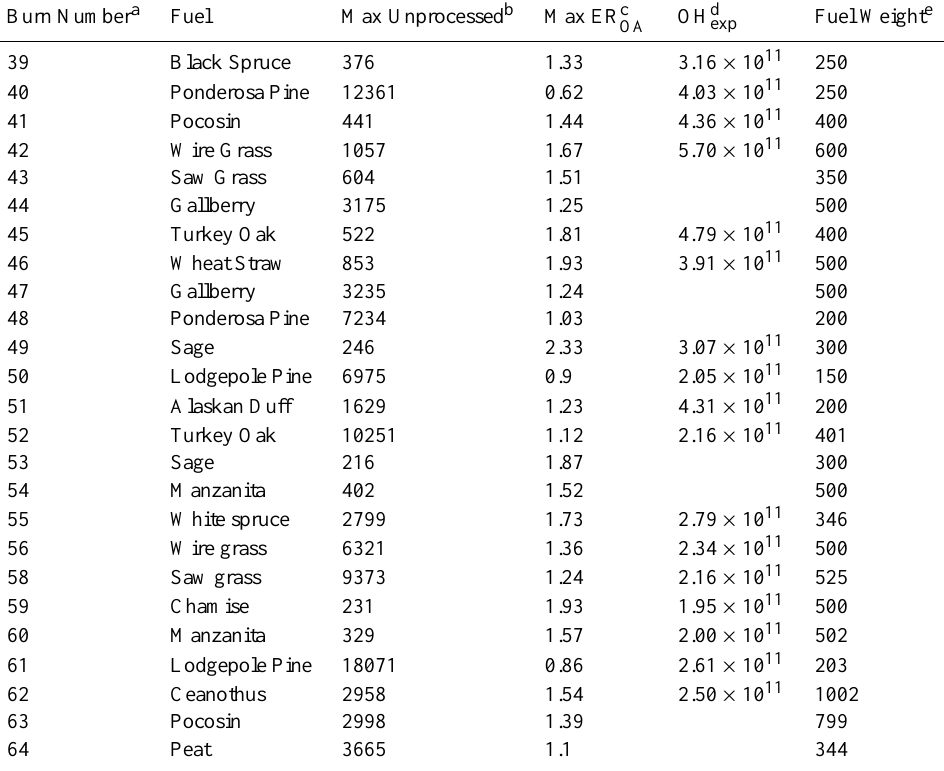
Table 1. Experimental results of each fuel from FLAME-3, with maximum (deviation from unity, ER OA = 1) sustained 5min average organic aerosol enhancement ratio (ER OA ) with associated OH exposure (OH exp ) , maximum unprocessed OA mass concentration, and starting weight of the biomass mass fuel before combustion. In some experiments, the O 3 monitor malfunctioned, and thus OH exp could not be estimated; however, OH in the reactor was always scanned using the same methodology